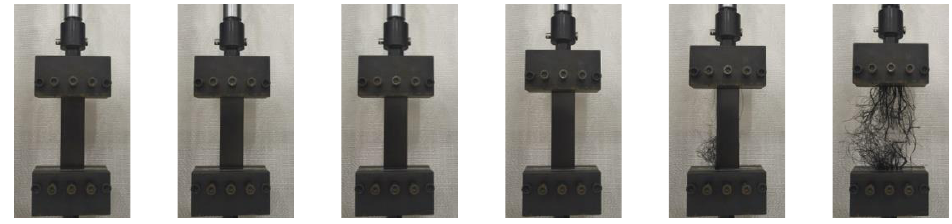
Figure 9. The tension process of a PP specimen.